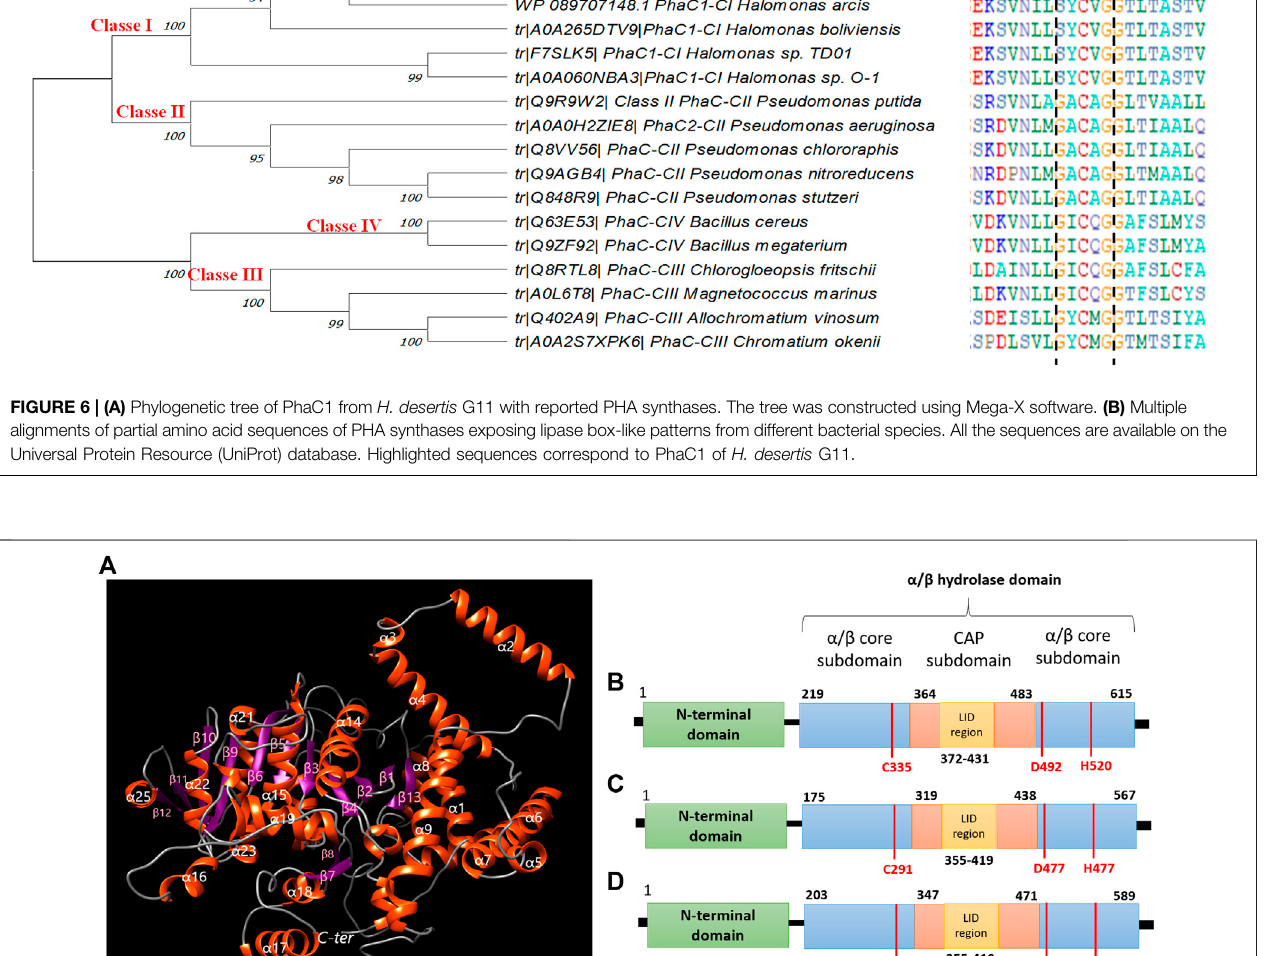
Frontiers in Bioengineering and Biotechnology |